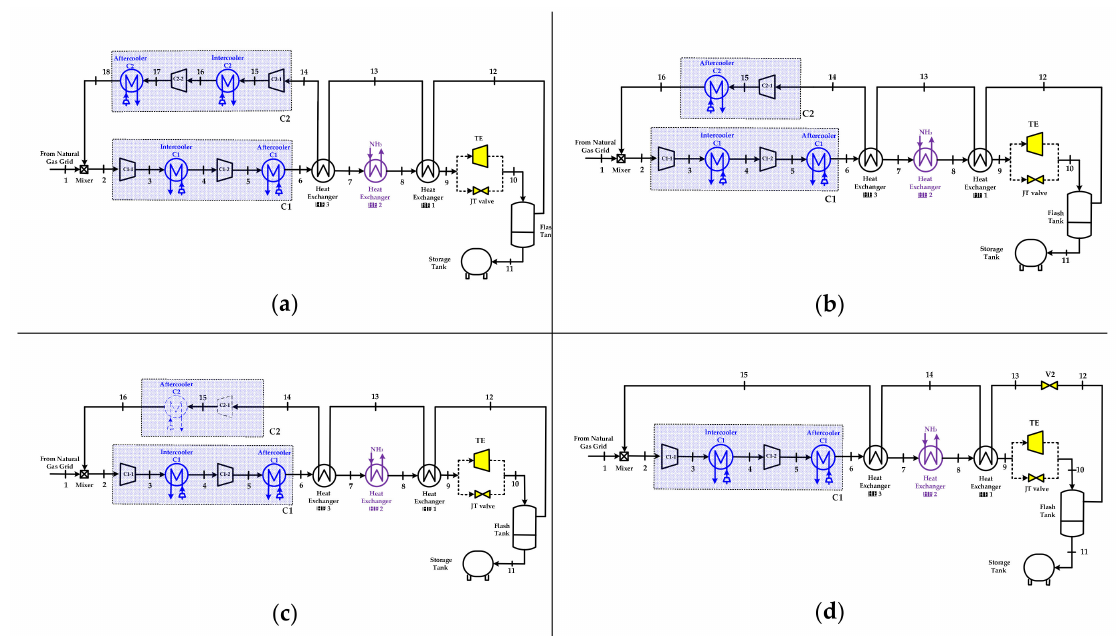
Figure 2. Optimum layouts for the considered supply pressure scenarios: ( a ) high pressure supply network (HPN), ( b ) medium-high pressure supply network (MHPN), ( c ) medium-low pressure supply network (MLPN), ( d ) low pressure supply network (LPN). Table 2. Optimized results of parametric